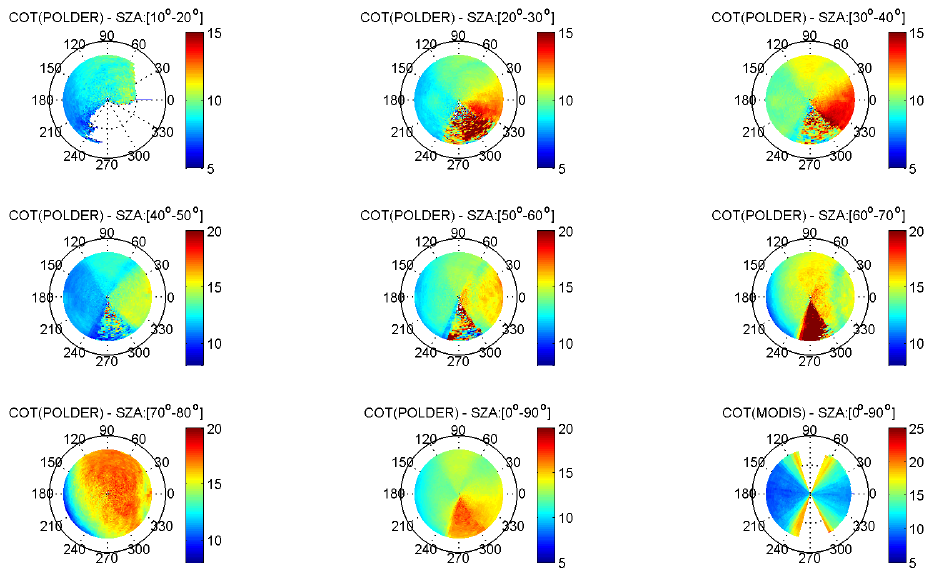
Fig. 8. Polar graphs of POLDER COT for overcast oceanic liquid clouds for different solar zenith angles (1st, 2nd lines and the 1st column of the 3rd lines) and of MODIS COT for all sun incidence angles (lower right corner). Polar angle represents relative azimuth angle between the satellite and the sun (from 0 ◦ corresponding to backscattering direction to 359 ◦ ). Polar radius corresponds to the sinus of the satellite zenith angle (from sin 0 ◦ = 0 to sin 90 ◦ = 1). Colors encode the averaged COT values for a given set of geometries. SZA means solar zenith angle range. There is a poor satellite sampling for relative azimuth angles between 240–300 ◦ for POLDER and between 60–120 ◦ and 240–300 ◦ for MODIS.